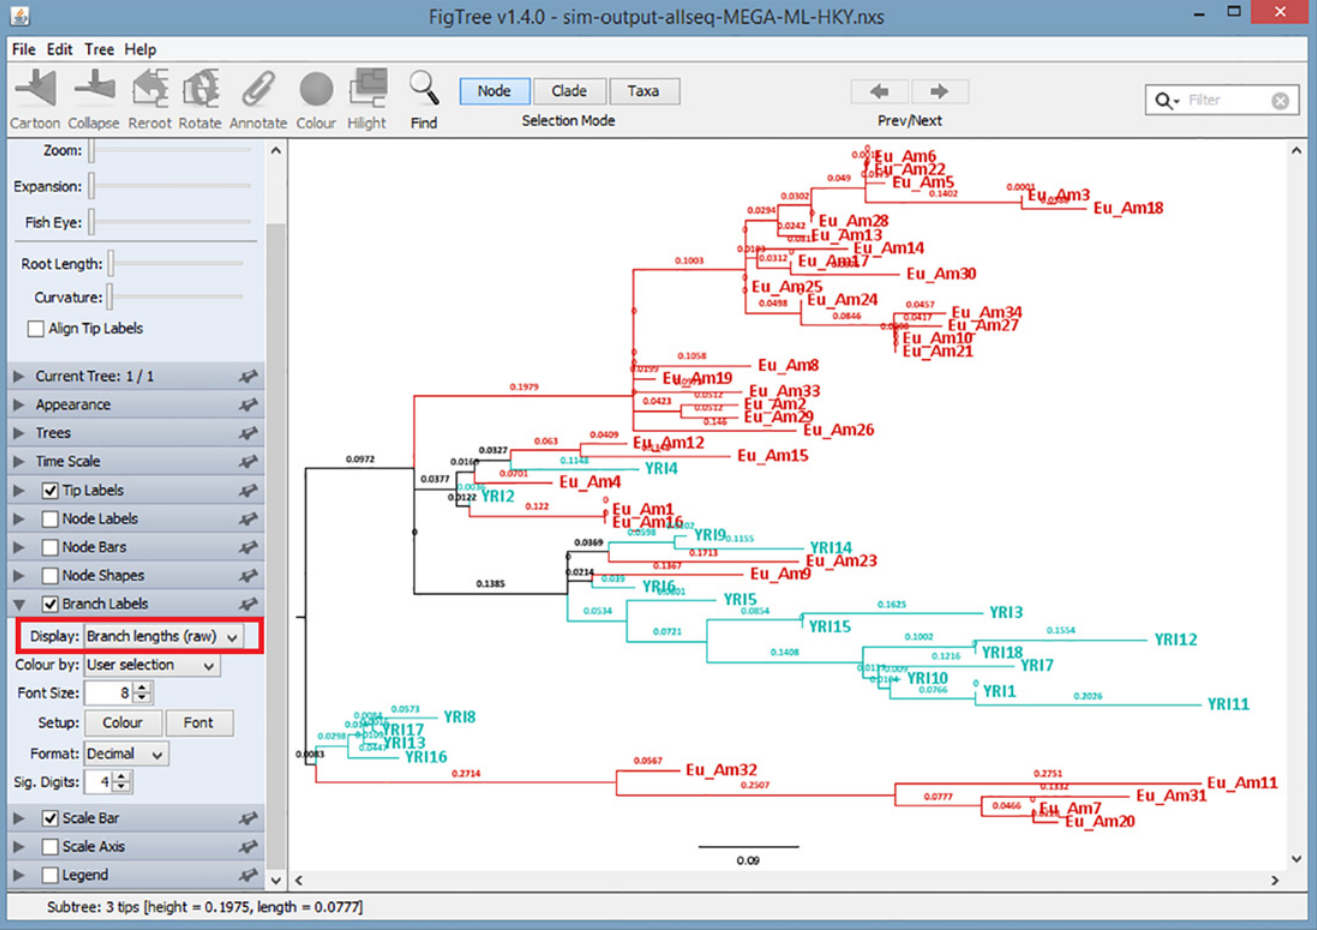
Fig 8. An Example of Distances Support in the